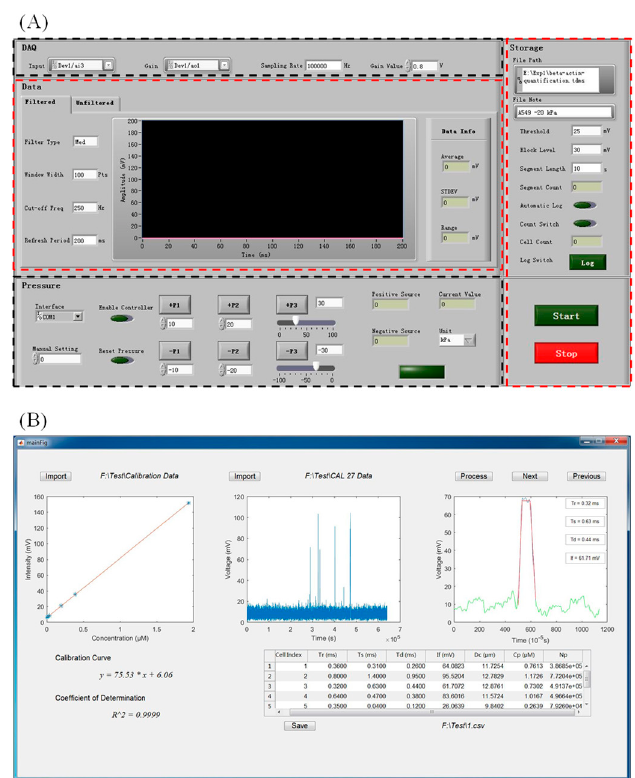
Figure 3. ( A ) The interface of the LabVIEW Platform for instrument operation mainly included the top-left and bottom-left areas for the regulations of the fluorescent and the pressure modules, respectively. The middle area displayed the sampled voltages collected by the data acquisition card (DAQ) in a real-time manner, and the right area displayed the parameters for the storage of the collected signals. ( B ) The interface of the MATLAB-based data processing mainly included the import of the calibration curve (left), the import of the raw voltage data indicating fluorescent intensities (middle), and the curve-fitting of individual fluorescent pulses (right). Based on these steps, the numbers of protein copies for individual cells were obtained and displayed at the bottom of this interface.